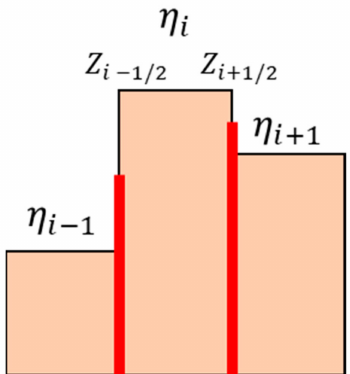
Figure 4. The calculated parameters of a shallow water equation with no special